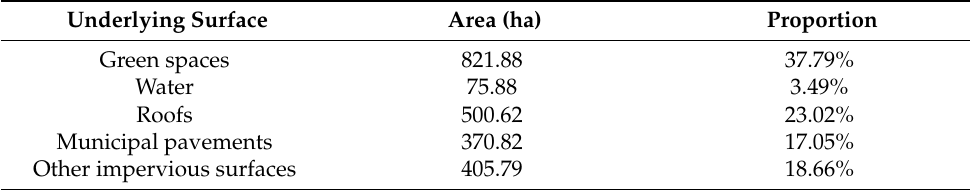
Table 4. Proportion of underlying surface types.